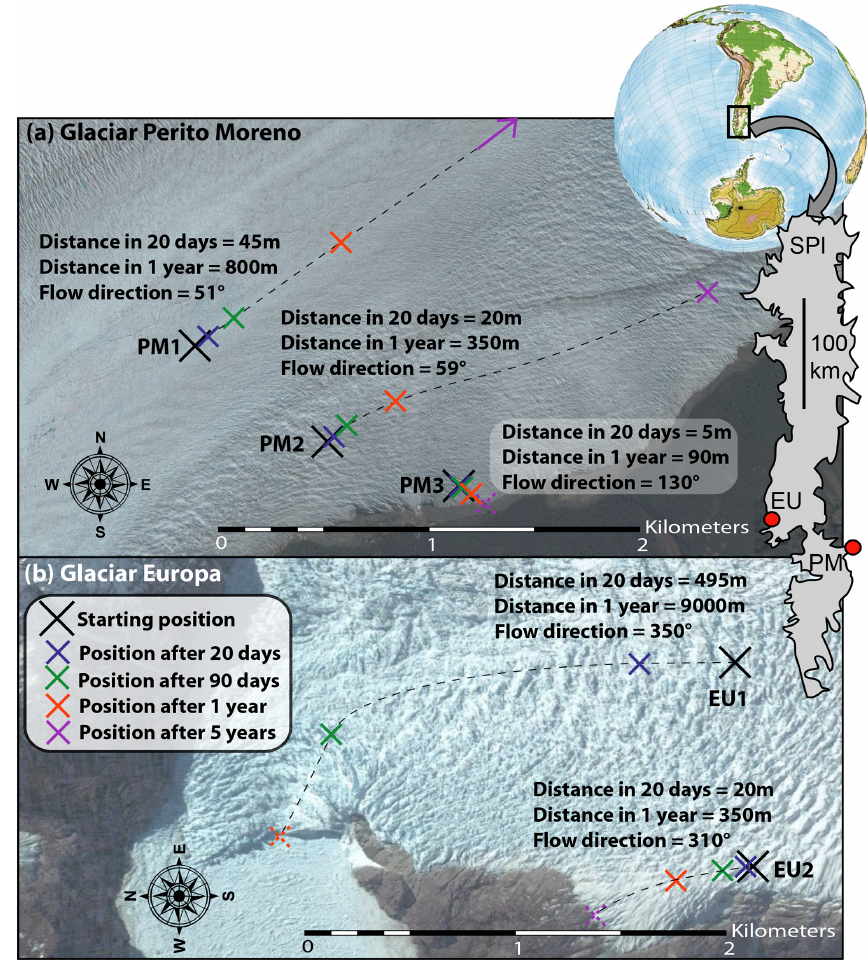
Figure 6. (a) Position of a point on Glaciar Perito Moreno (PM) with the time for three different starting locations within 2km of the glacier’s southern margin. At PM1, ice speeds reach 800myr − 1 , and any equipment will be rapidly displaced. At PM3 ice-flow speeds are < 100myr − 1 and oriented towards the valley edge. (b) Identical plot for two points on Glaciar Europa (EU). Any equipment installed at EU1 will be displaced several kilometres and lost to calving in less than 6 months. The inlay shows an outline of the Southern Patagonian Icefield (SPI) with the locations of the two glaciers. Imagery © Google